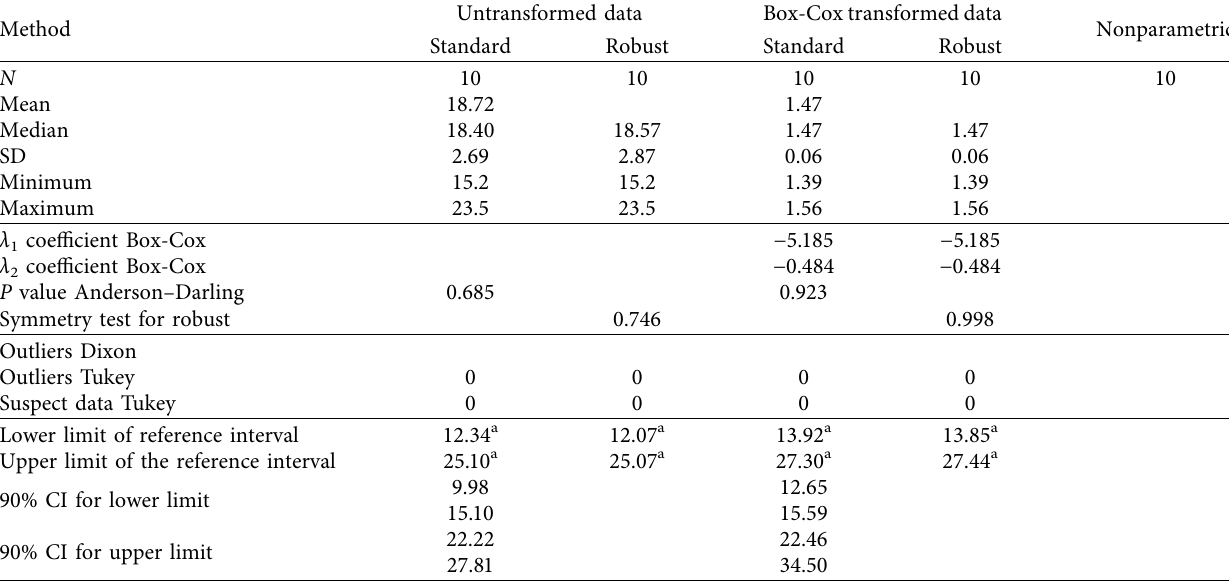
Figure 5: Histograms show the two tested analyte distributions. EBCR onset latency (a) exhibits a Gaussian distribution, whereas the EBCR mean baseline to peak amplitude (b) exhibits a non-Gaussian distribution. Table 2: Computations made with a series of 10 EBCR onset latency values